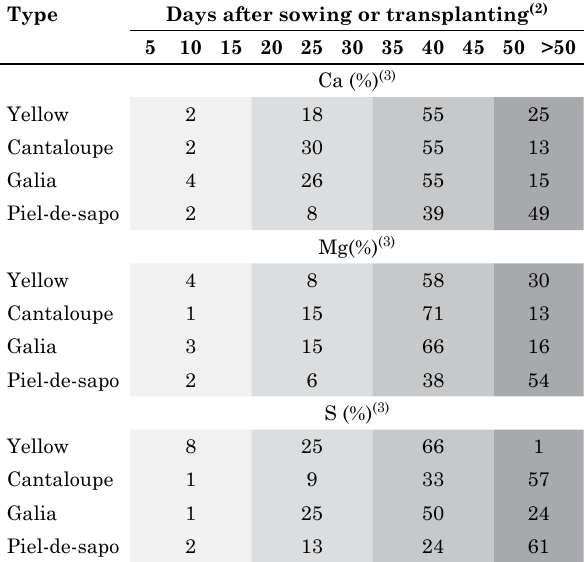
Table 8. Ferticalc-melon recommendations for relative distribution of Ca, Mg, and S nutrients in topdressing (fertigation)